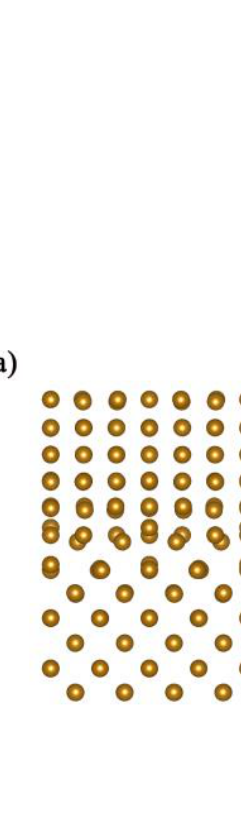
Figure 1. Model, ELF, and DOS of pure homojunction after optimization. ( a – c ) The model, DOS, and ELF, respectively. In ( b ), from top to bottom, the DOS of austenitic Fe at the interface, ferrite Fe at the interface, bulk-phase austenitic Fe, and bulk-phase ferrite Fe.